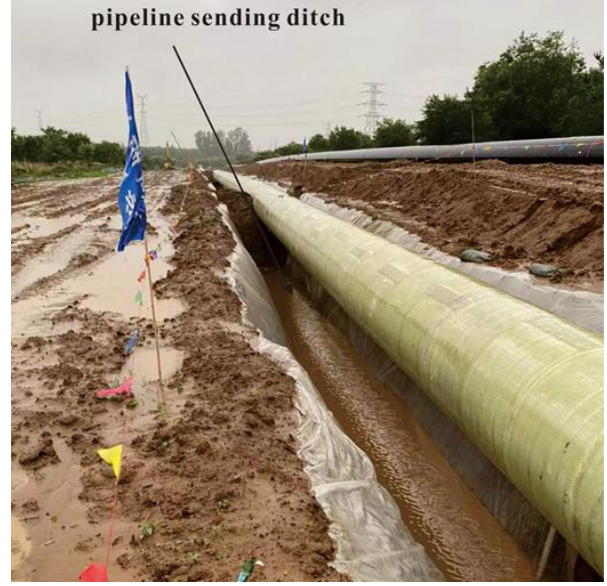
Figure 14. Pipeline sending